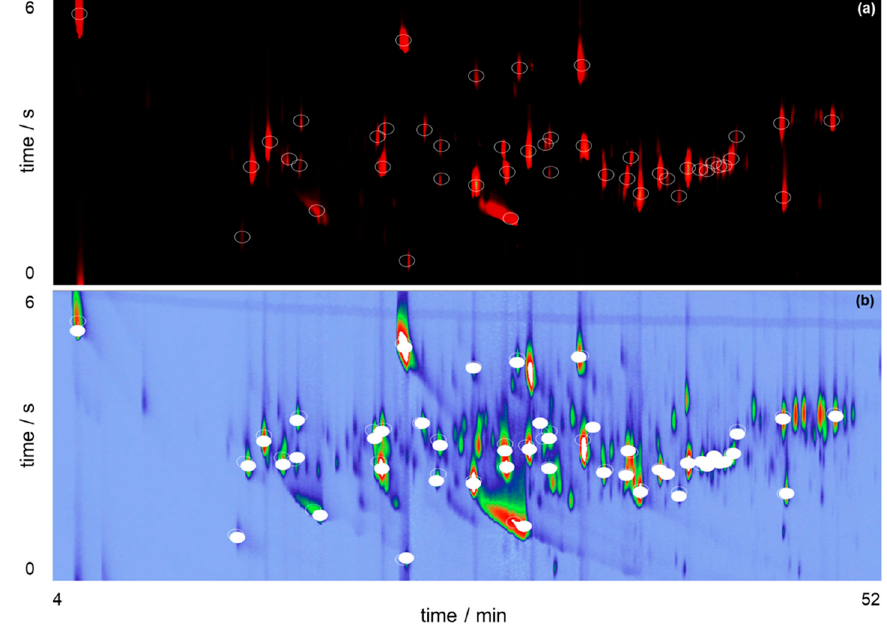
Figure 5. ( a ) Peak template creation using the loadings vector and the reconstructed chromatogram; ( b ) Process of template matching using GC Image highlighting potential unique compounds in the GC × GC-QMS total ion chromatogram of the BR beer sample.